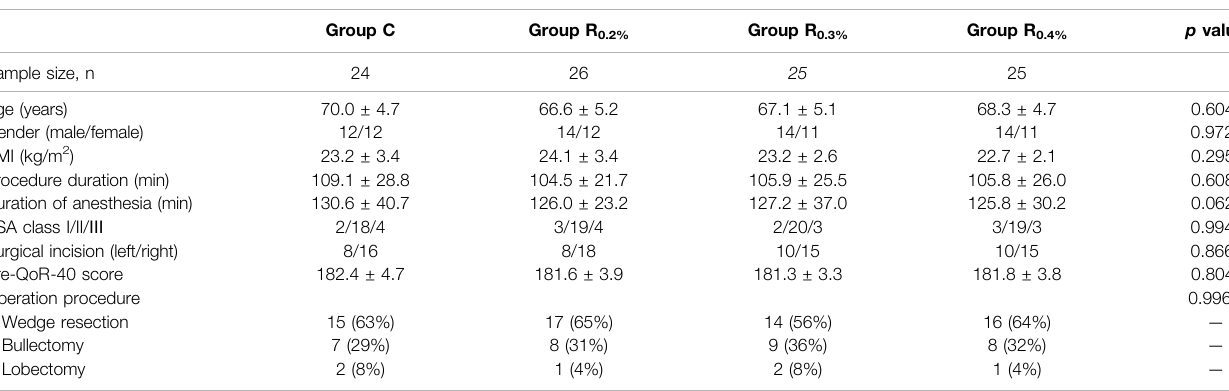
TABLE 1 | Descriptive variable characteristics of patients in four groups ( (cid:1) x ±